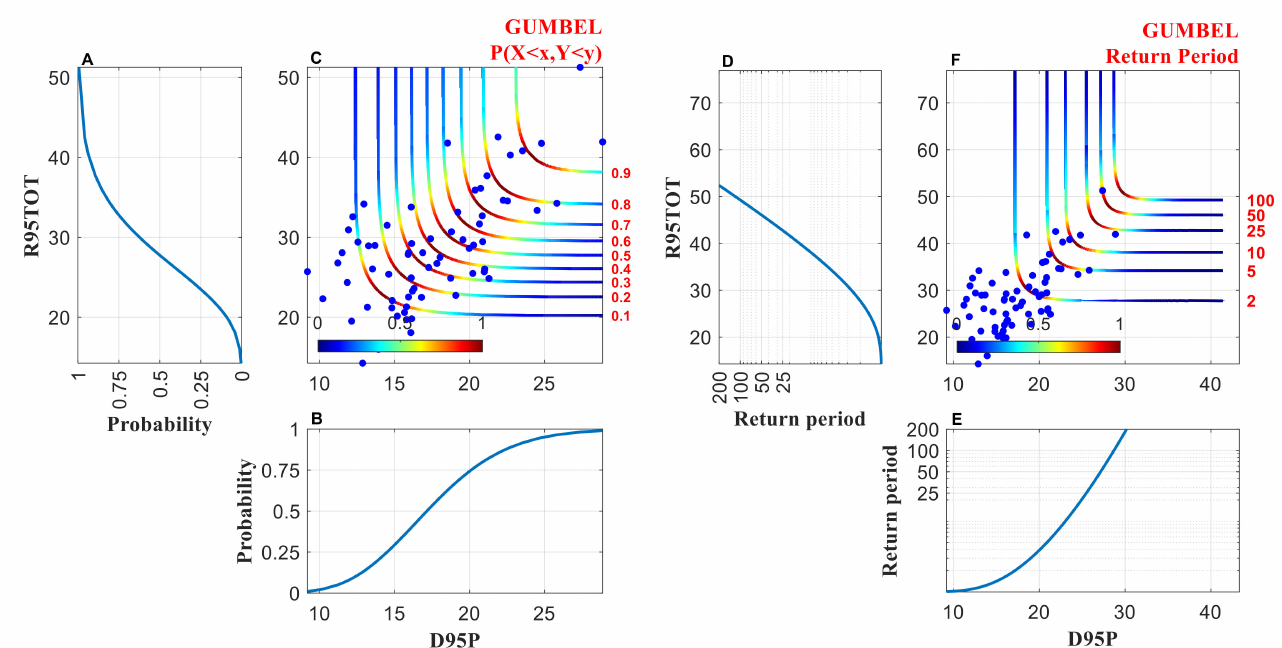
Figure 9. Same as Figure 8 but for a combination of climate indices R95TOT and